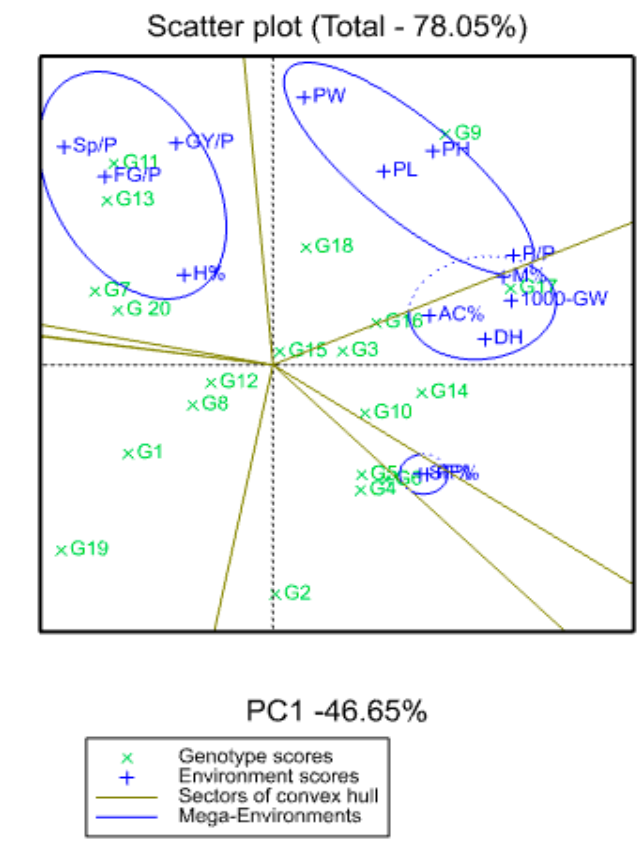
Figure 11. Genotype-by-trait (GT) biplot, showing the genotype-by-trait data. PC1 and PC2, as the main PCs, analyzed the diversity of the agronomic characteris- tics of the genotypes studied. The results of the PCA of the agronomic characteristics of the genotypes studied showed that PC1 and PC2 were the best PCs in identifying the diversity between yield and its components, while PC4 was the optimal PC in identifying the diversity between grain quality traits (Figure 11 and Table 11).